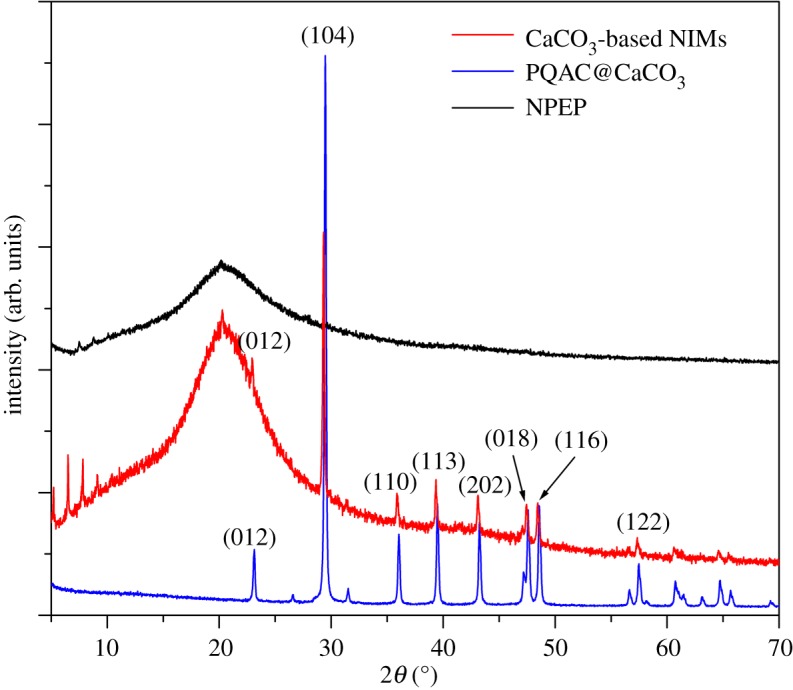
XRD patterns of CaCO3-based NIMs, PQAC-CaCO3 nanoparticles and pristine NPEP.